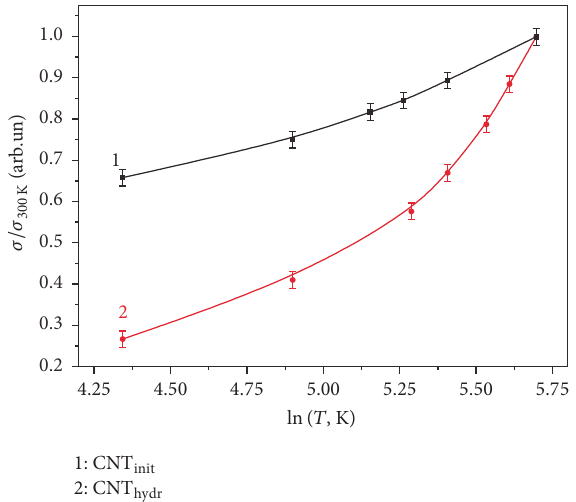
Figure 5: Temperature dependencies of the electroconductivity of conical carbon nanotubes. Line1(CNT init ): averaged linewith errors for 5 initial samples, Line 2 (CNT hydr ): averaged line with errors for 5 electrochemically hydrogenated samples, 𝜎 300 K : electroconductivity at 300